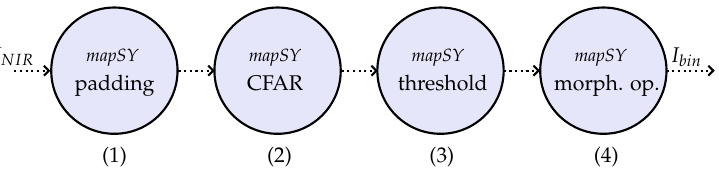
Figure 5. ForSyDe model for the vessel detection algorithm using the synchronous model of com- putation (modified from [12]). In ( 1 ), a padding operation is performed in the tile borders. CFAR normalization is applied in ( 2 ), followed by a threshold operation (with value τ 4 ) in ( 3 ). Then, morphological operations are applied in ( 4